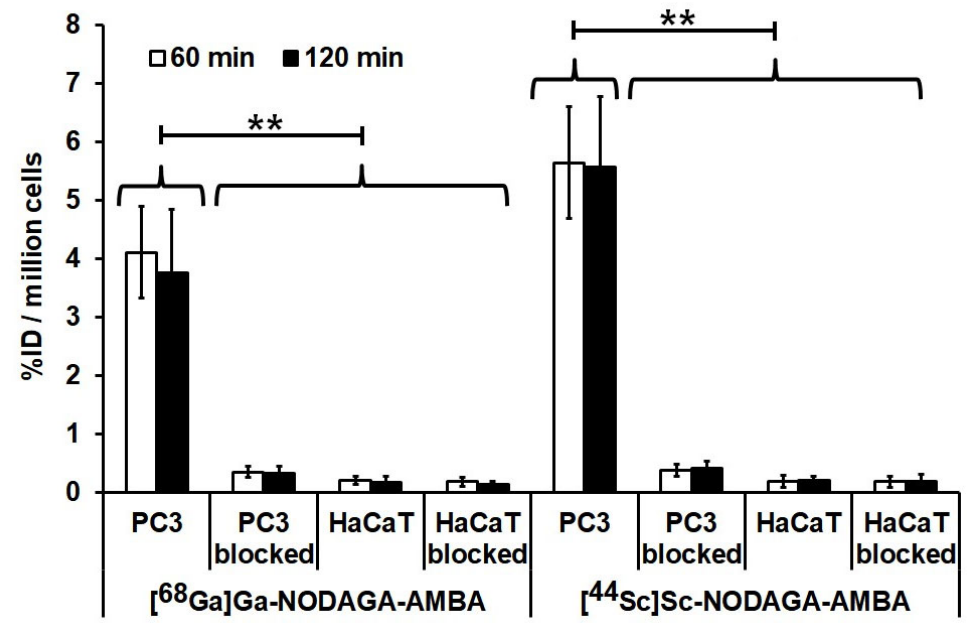
Figure 2. Assessment of in-vitro cellular uptake studies of gastrin-releasing peptide receptor (GRPR)-specific [ 68 Ga]Ga-NODAGA-AMBA and [ 44 Sc]Sc-NODAGA-AMBA radiopharmaceuticals. Comparison of radiotracer uptake results of GRPR-positive PC-3 and negative HaCaT cells after 60 and 120 min incubation time in the presence and absence of 200 nM bombesin (BBN) as a blockade. Significance level between the PC-3 cells and the blocked PC-3 or HaCaT cells: p ≤ 0.01 (**). %ID: Radiotracer accumulation in 10 6 cells was expressed as the percentage of the incubating dose. The data shown are means ± SD of the results of at least three independent experiments, each performed in